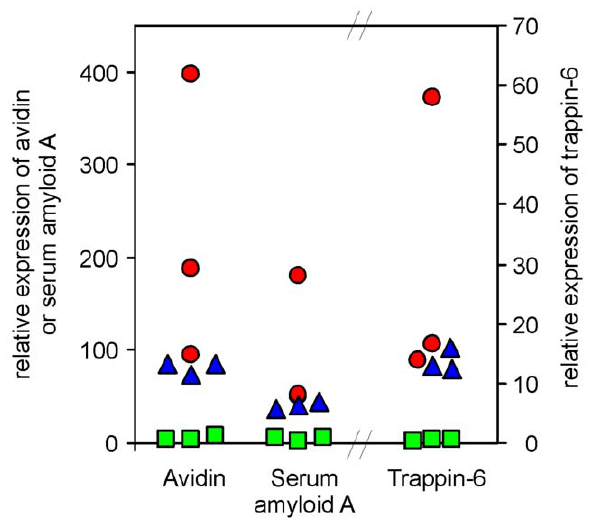
Figure 2. Expression and induction of avidin, serum amyloid A and trappin-6 in macrophages sorted from spleens of non- infected, infected, and vaccinated and infected chickens. Squares –3 non-infected chickens; circles –3 infected chickens; triangles –3 vaccinated and infected chickens.